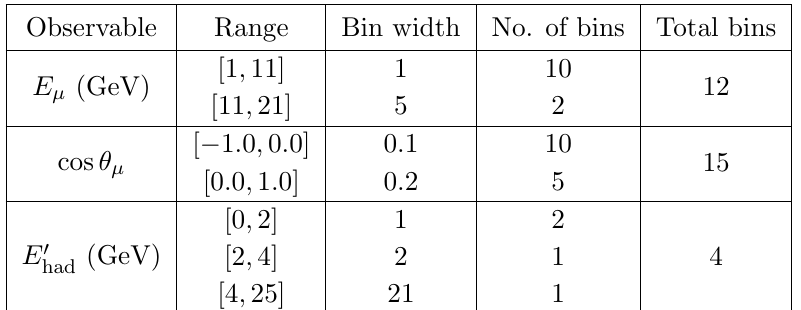
Table 2 . The binning scheme considered for the reconstructed observables E (cid:22) , cos (cid:18) (cid:22) , and E 0 for each muon polarity. In last column, we give the total number of bins taken for each